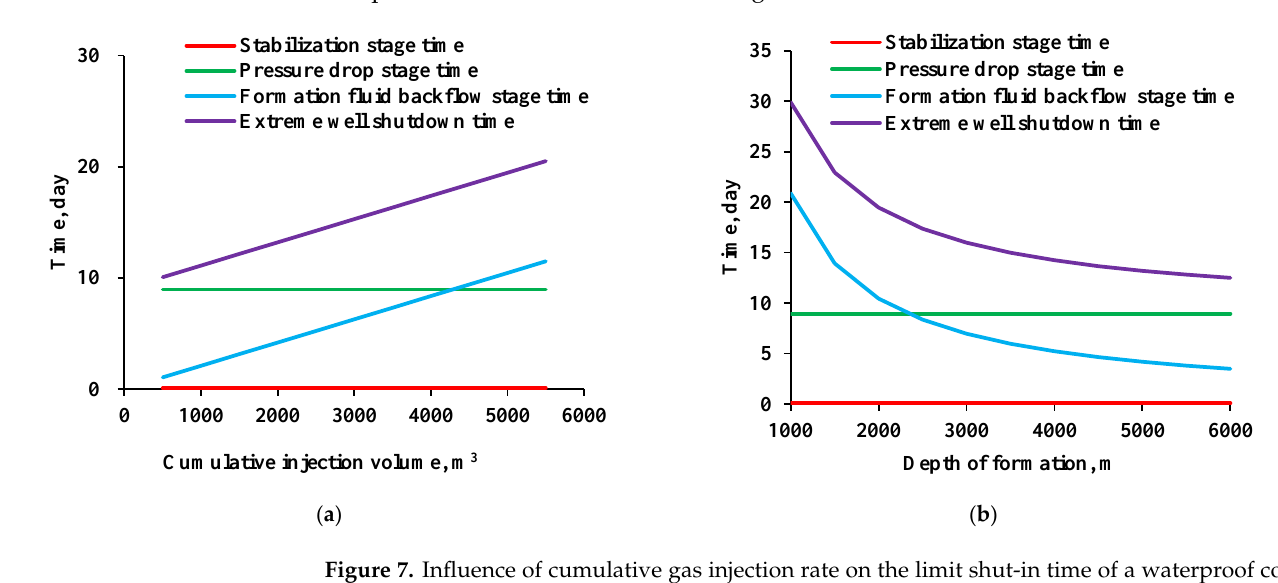
Table 3. Hydrate blockage in the wellbore of carbon dioxide injection wells.